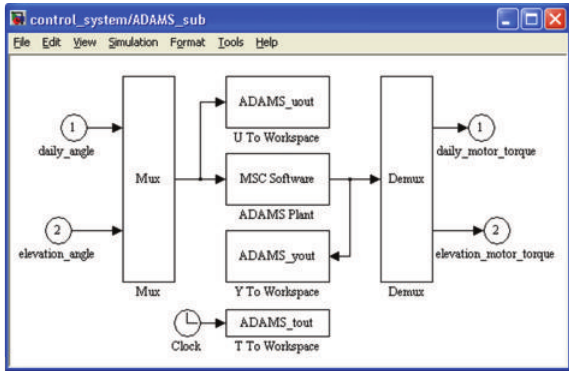
Figure 6: The mechanical device block in MATLAB/Simulink.